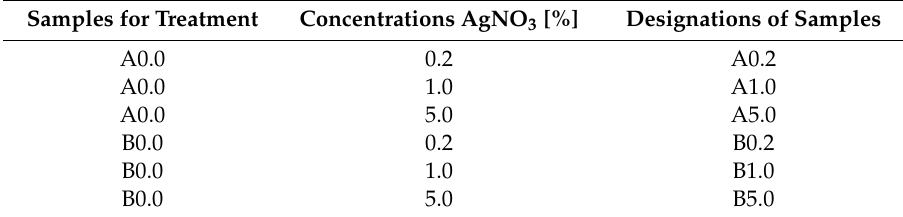
Table 3. The applied concentrations and designations of samples in this study. Samples for Treatment